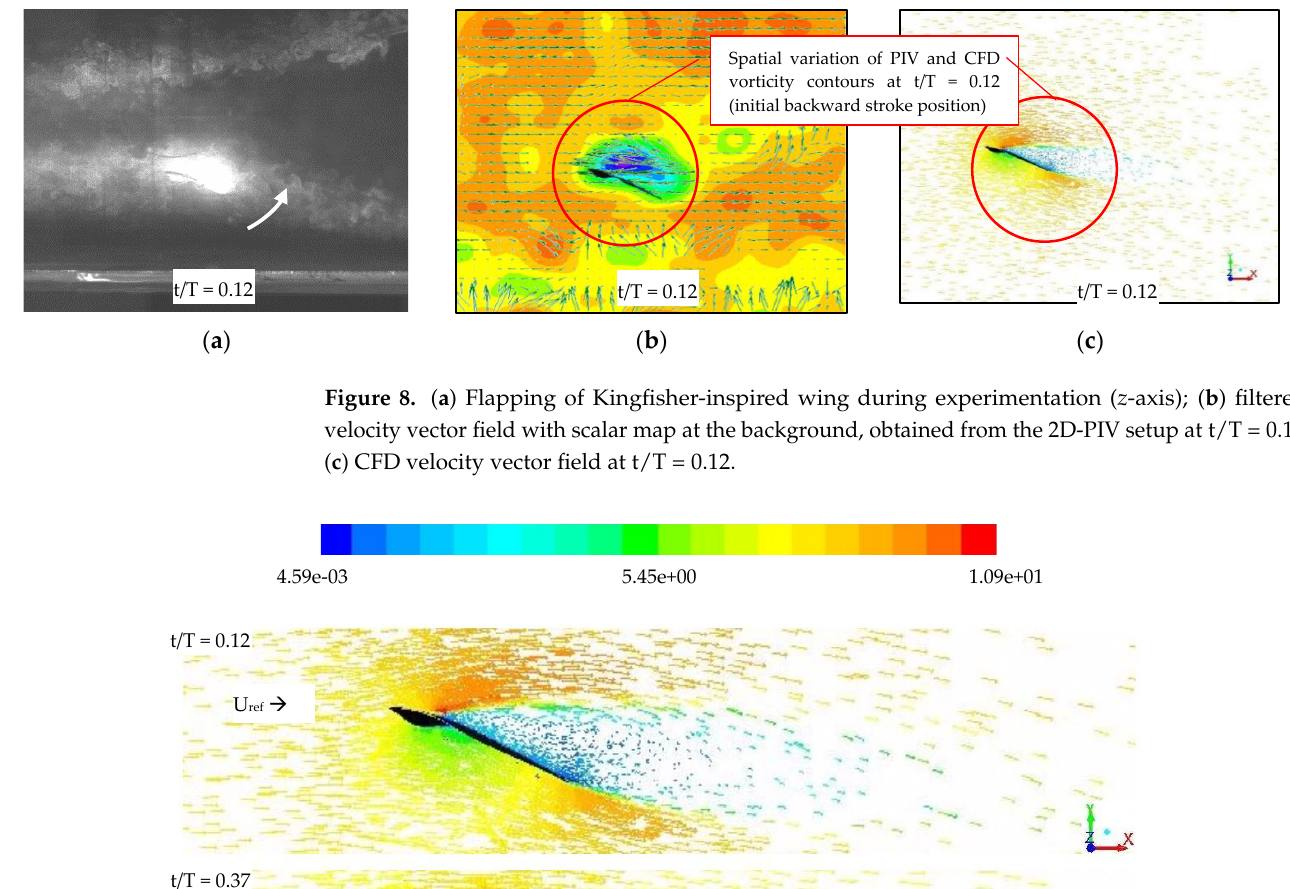
Spatial variation of PIV and CFD vorticity contours at t/T = 0.12